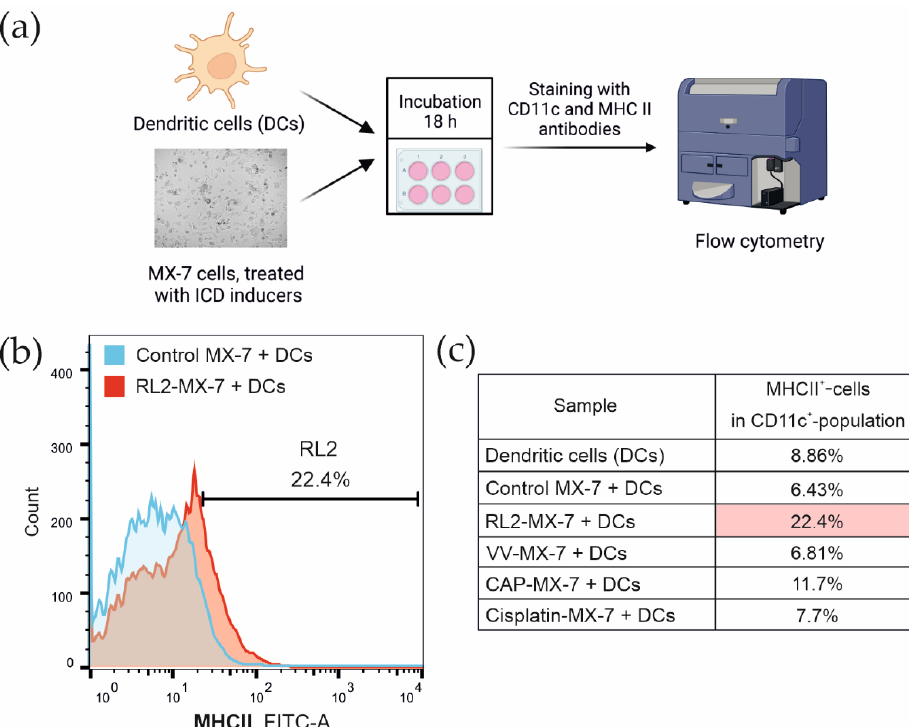
Figure 4. Maturation of bone marrow dendritic cells (DCs) form C3H/He mice after incubation